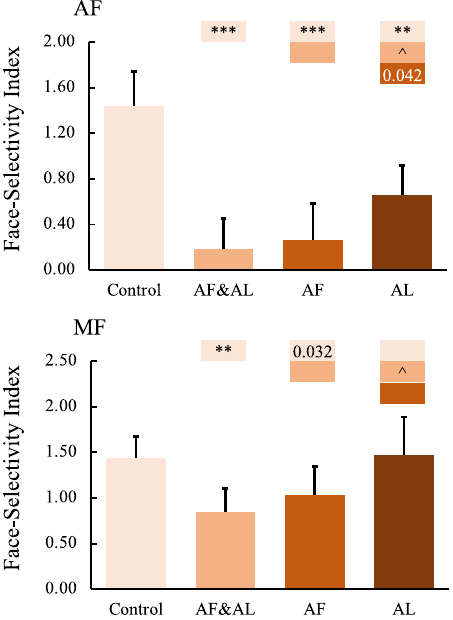
Fig.5|Effectsofanteriorfacepatchinactivationonface-selectivityindexinthe ipsilateraltemporalfacepatches. The name of the ROIis shown atthe top leftof eachpanel.AF&AL:combinedAFandALinactivation;AF:AFaloneinactivation;AL: AL alone inactivation. P values were calculated with bootstrap tests ( n =10,000) adjustedformultiple testing using the Holm-Bonferronimethod.Color bars above a particular histogram contain the statistical results of comparing this inactivation condition and the condition to its left with the same color as the bar: *, signi fi cant